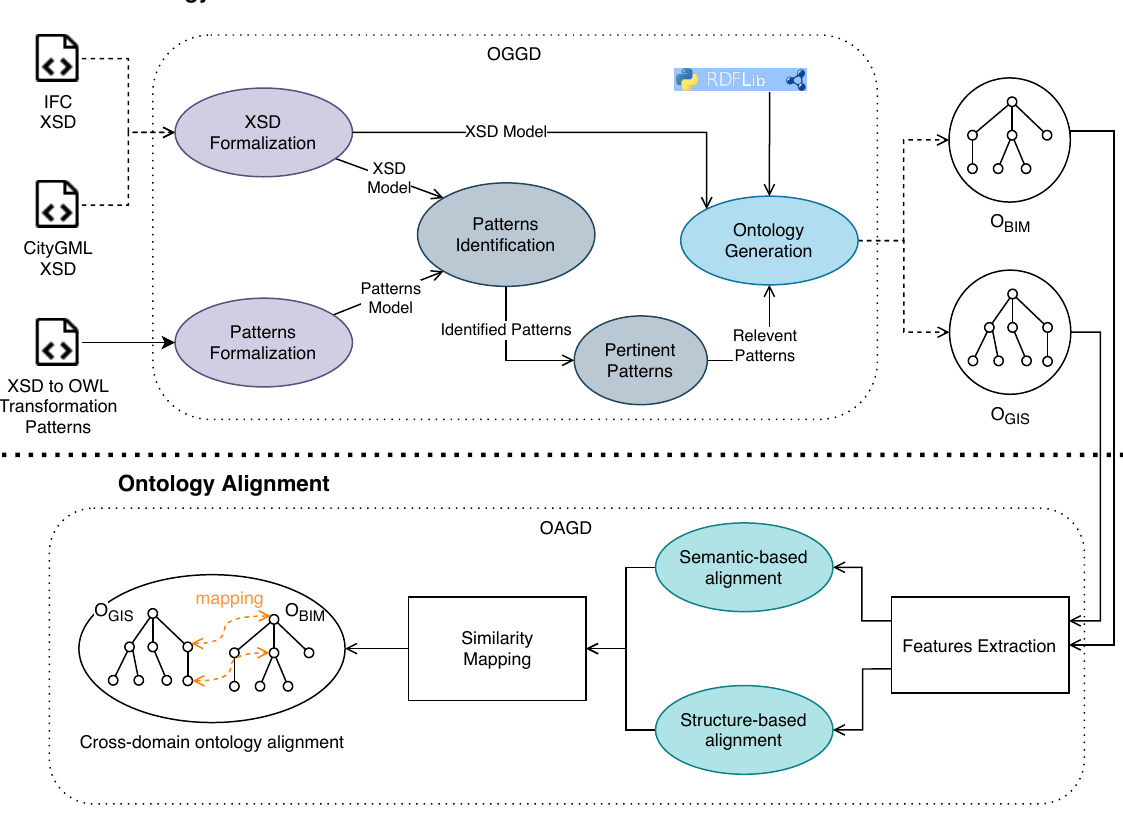
Figure 1. Framework for ontology generation and alignment table as key and value pair for efficient retrieval. Next, to